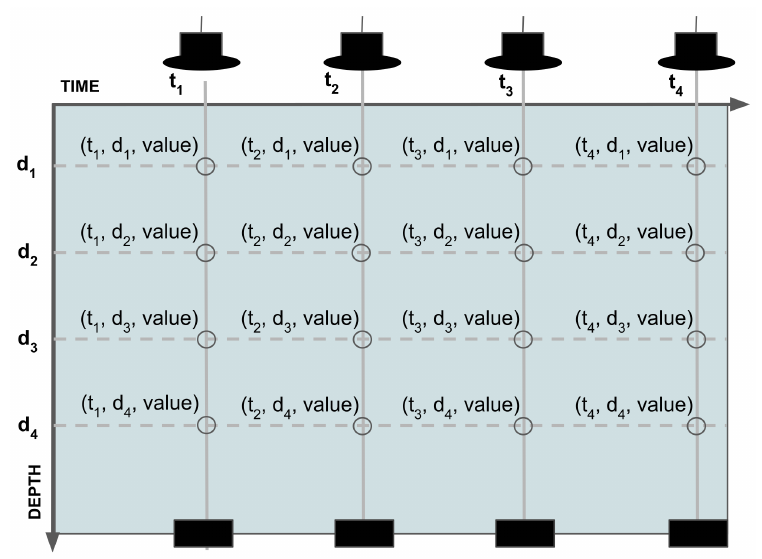
Figure 10. Profile data